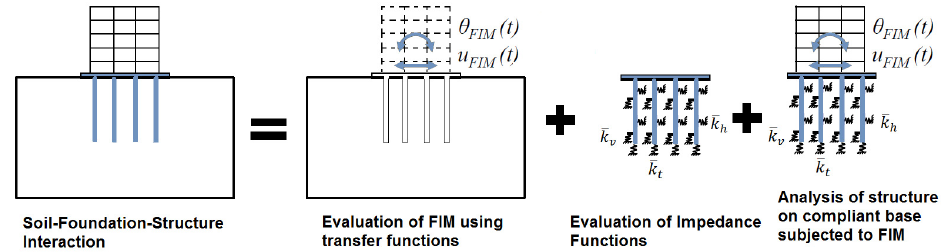
Figure 2. Direct and substructure methods in the soil–pile–structure